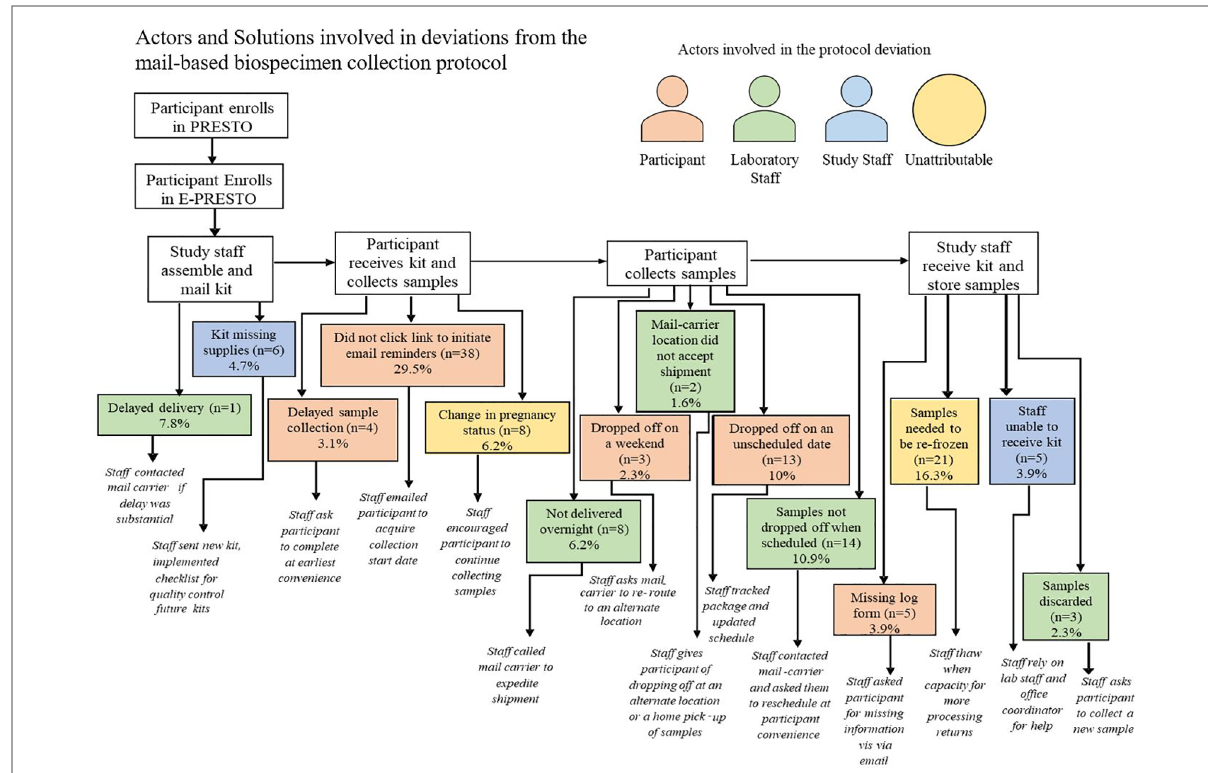
FIGURE 5 Actors and solutions involved in deviations from the mail-based biospecimen collection protocol among participants who complete the